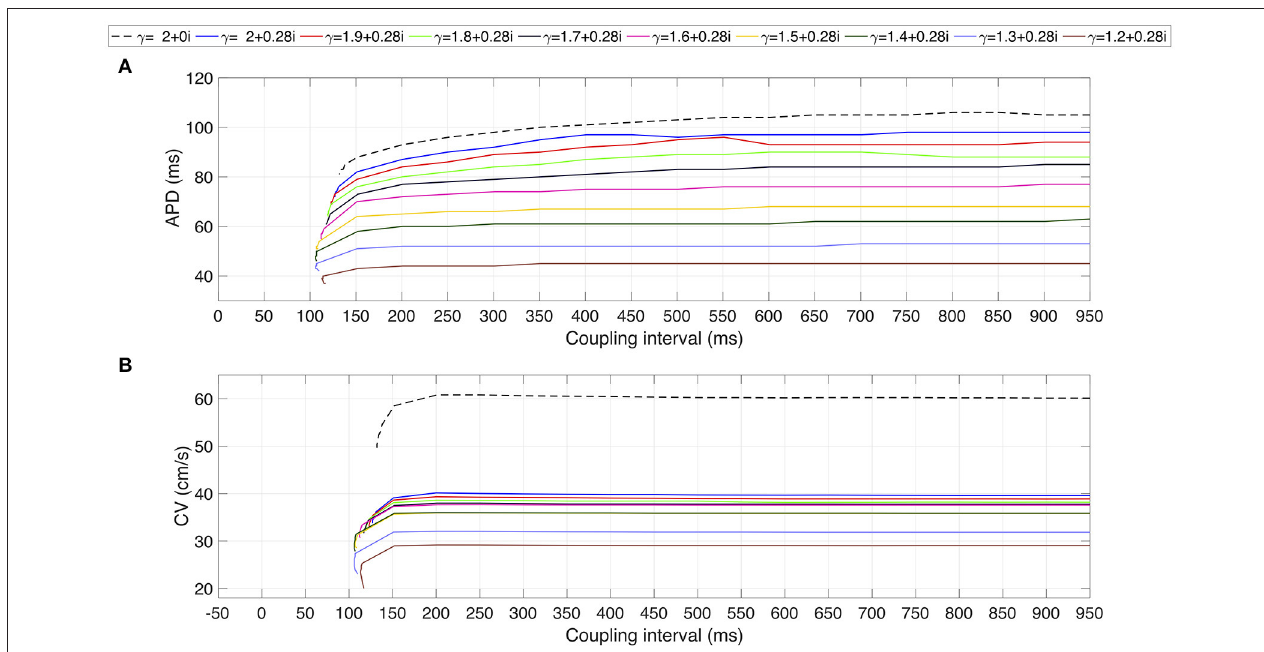
FIGURE 5 | Restitution curves for several test values of γ . (A) APD restitution curve. (B) CV restitution curve. Dashed line corresponds to standard diffusion and colored curves correspond to test values of γ .